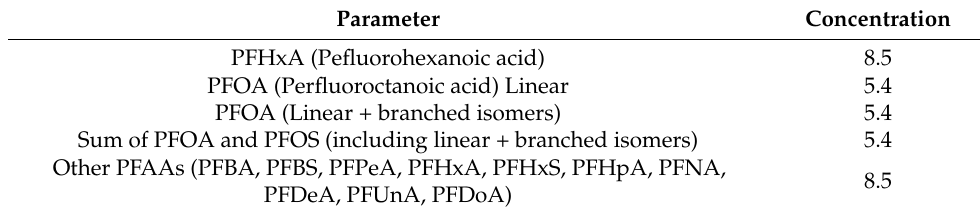
Table 5. Polynuclear aromatic hydrocarbons, perfluorinated alkyl substances, chlorinated insecticides and herbicides resulted above the respected detection limits in the effluent wastewater (average values, in